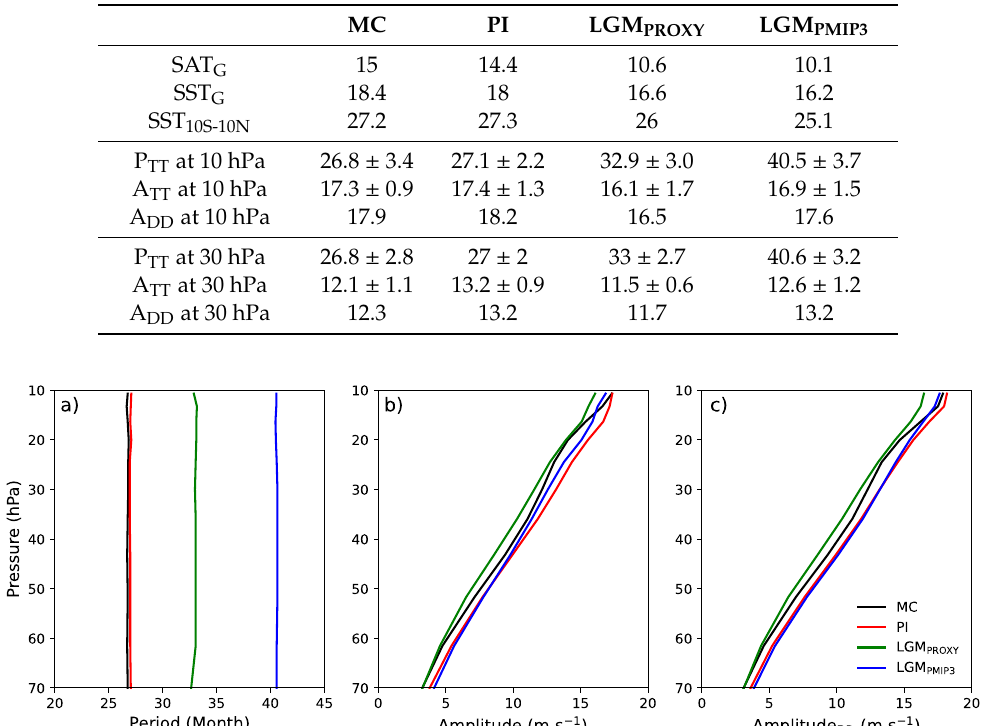
Table 1. Globally-averaged surface air temperature (SAT G ) ( ◦ C); globally-averaged sea surface temperature (SST G ); sea surface temperature averaged over 10 ◦ N / S (SST 10S-10N ); and quasi-biennial oscillation (QBO) mean period (P) (month) and mean amplitude (A) (m s -1 ) at 10 and 30 hPa from the MC, PI, LGM PROXY , and LGM PMIP3 simulations. Estimates of the QBO mean period and amplitude based on the transition time method are denoted by P TT and A TT , respectively, and the standard deviation follows the ± sign. The mean amplitude derived following Dunkerton and Delisi (1985) is denoted as A DD .